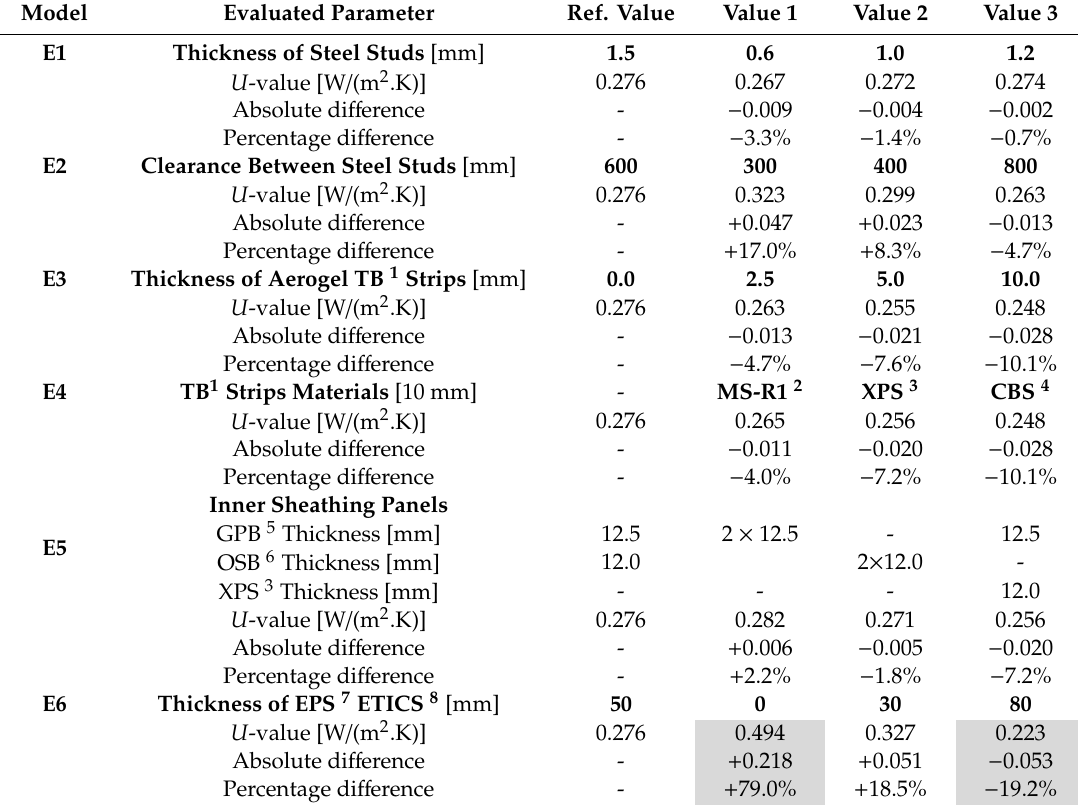
Table 9. Thermal transmittances obtained for exterior LSF facade